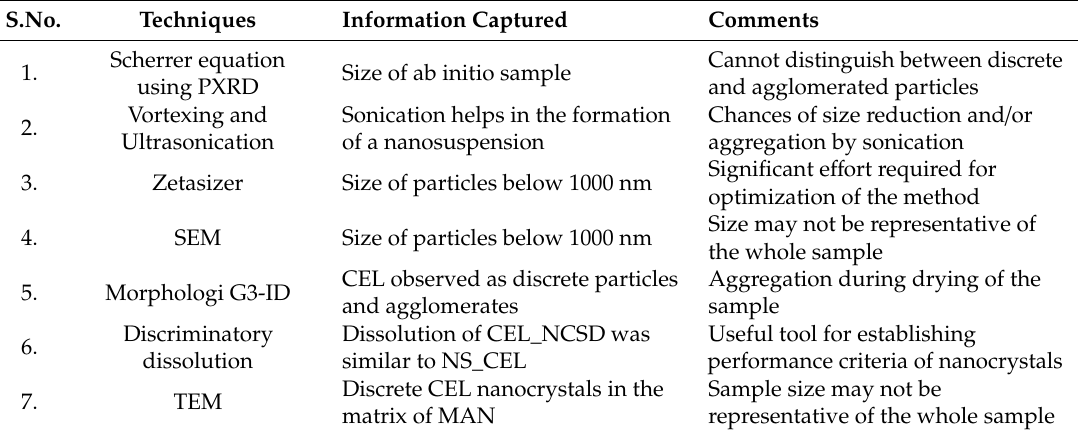
Table 5. Summary of information captured and limitations of various size determination